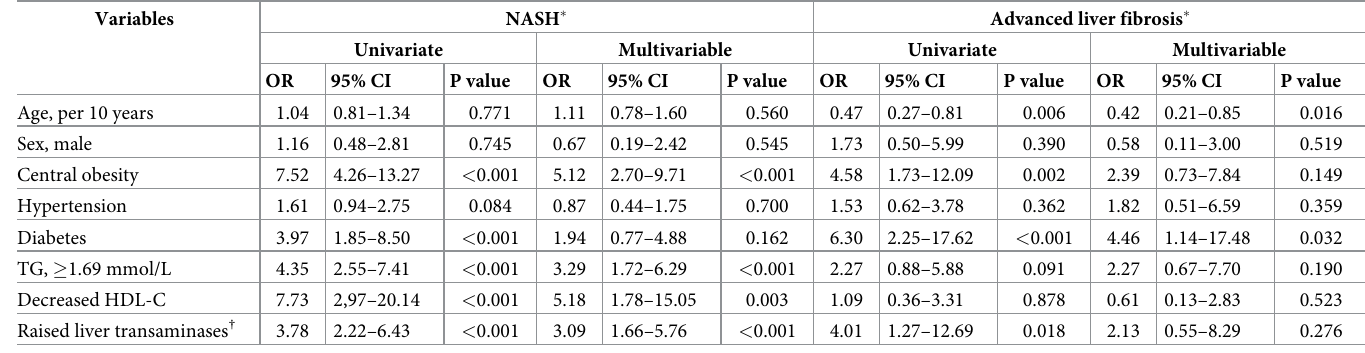
Table 6. Factors associated with NASH and advanced liver fibrosis in fatty liver from multivariable logistic regression analysis.